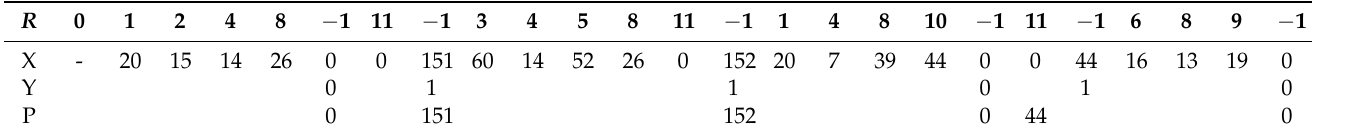
Table 8. Correction for i = 4 in